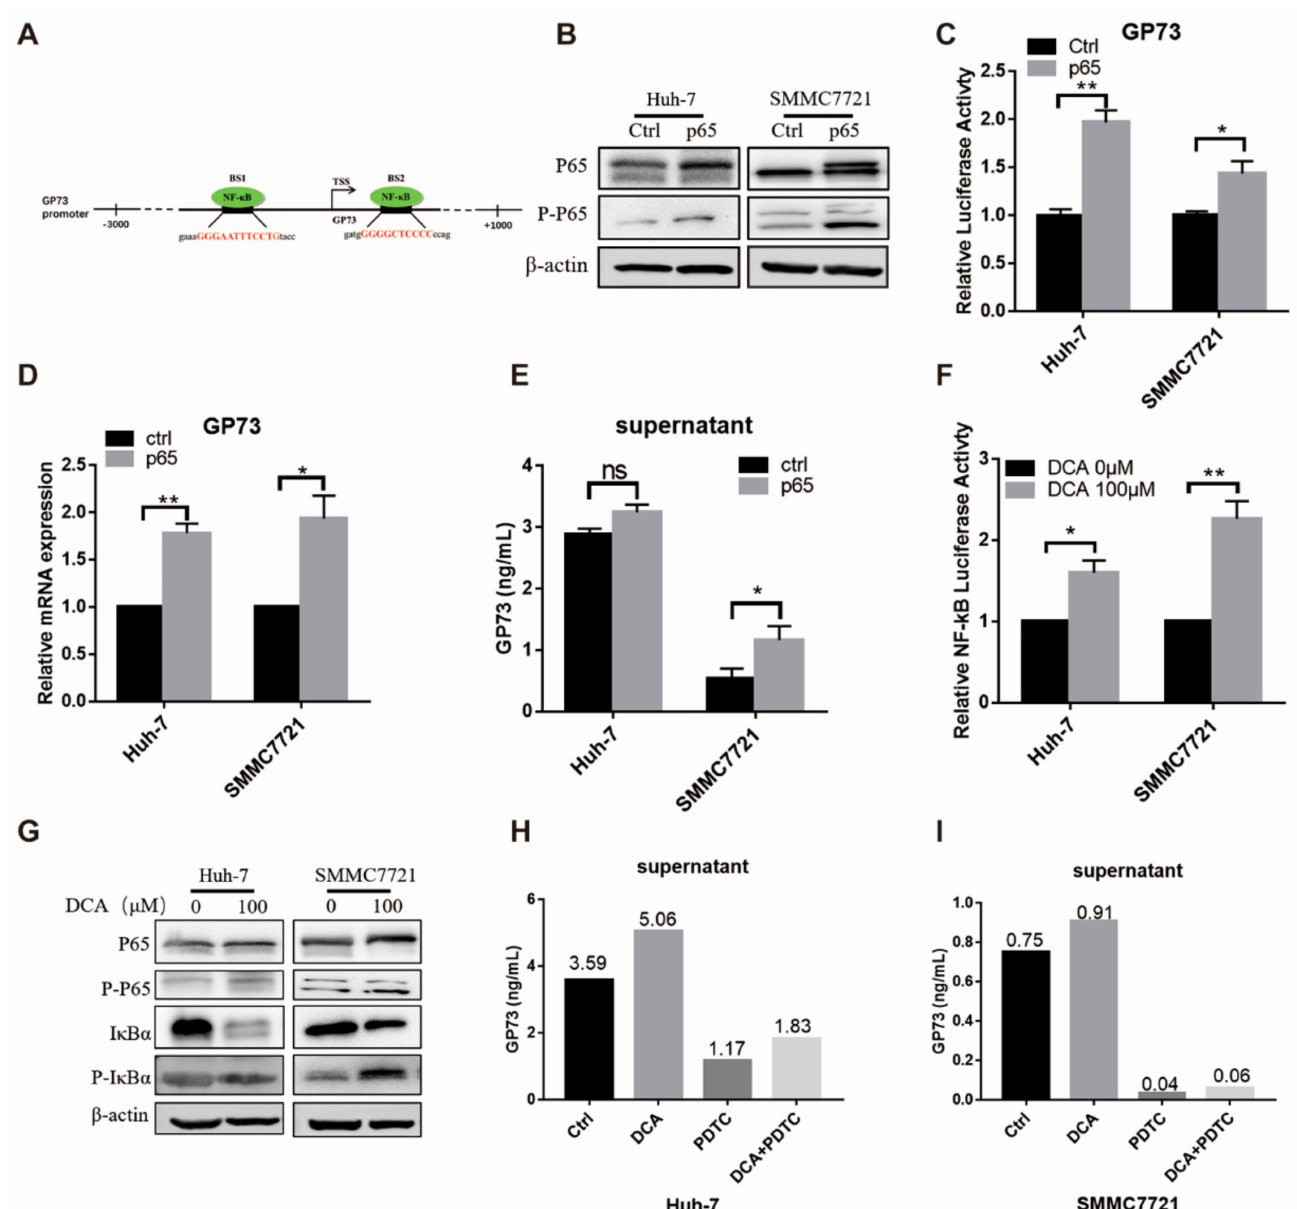
Figure 3. Deoxycholic acid (DCA) upregulates the expression of endogenous Golgi protein 73 (GP73) through activation of the NF- κ B pathway. ( A ) Schematic diagram of NF- κ B binding sites on GP73 promoter. ( B – D ) Huh-7 and SMMC7721 cells were transfected with PCMV-p65 or control PCMV vectors for 72 h. Samples were collected and a Western blot assay of NF- κ B P65 and P-P65 ( B ), detection of cell supernatant level of GP73 by ELISA ( C ), and qRT-PCR assay of GP73 mRNA level ( D ) were performed. ( E ) Huh-7 and SMMC7721 cells were transfected with PGL3-GP73 together with control vector PCMV or PCMV-p65. Luciferase activities were measured 48 h later. ( F ) Huh-7 and SMMC7721 cells were transfected with an NF- κ B-dependent firefly luciferase construct and treated with 100 µ M DCA. Samples were harvested 48 h after treatment, and luciferase activities were measured. ( G ) Huh-7 and SMMC7721 cells were treated with 100 µ M DCA for 72 h. NF- κ B pathway proteins were determined by Western blot assay. Cell supernatant levels of GP73 in Huh-7 ( H ) and SMMC7721 ( I ) cells exposed to 0.1% dimethyl sulfoxide (DMSO, ctrl) (Ctrl), 100 µ M DCA, 50 µ M pyrrolidine dithiocarbamate (PDTC), or 100 µ M DCA plus 50 µ M PDTC were detected by ELISA. Data in ( C – F ) are expressed as the mean ± SEM and represent three independent experiments (* p < 0.05; ** p < 0.01; *** p < 0.001; ns: not significant). Statistical analysis was performed using GraphPad